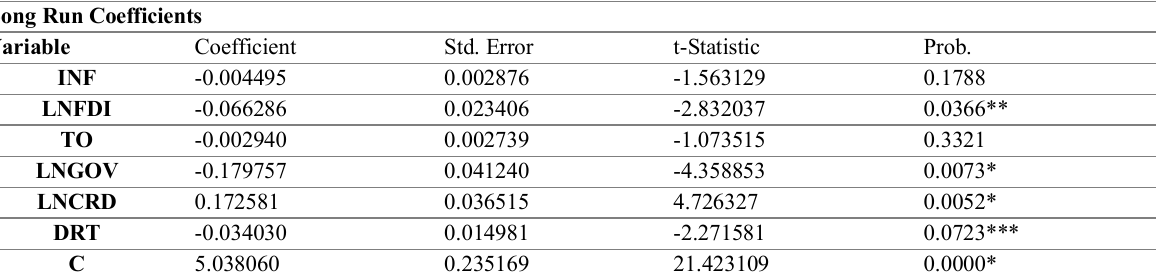
Table 5: Long run ARDL Estimation